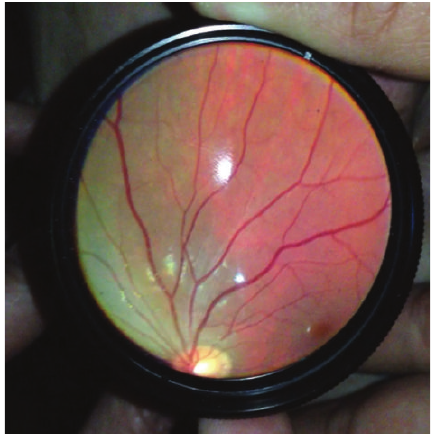
Figure 6: Large choroidal nevus imaged in the emergency depart- ment setting.